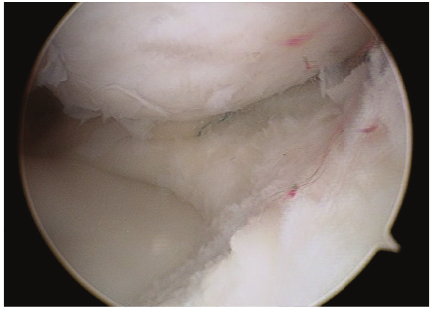
Figure 4: Arthroscopic image of the medial femorotibial compart- ment of the right knee from the anterolateral portal. Saucerization after the